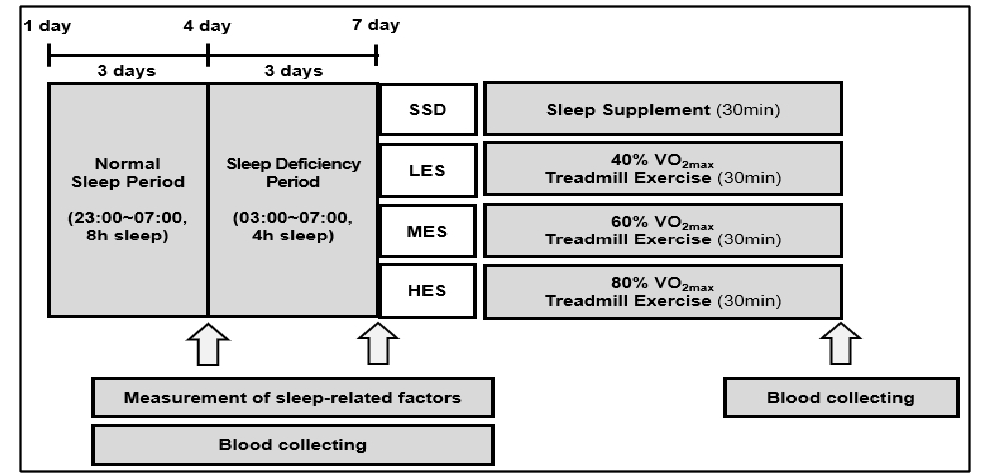
Figure 1. Experimental procedure.